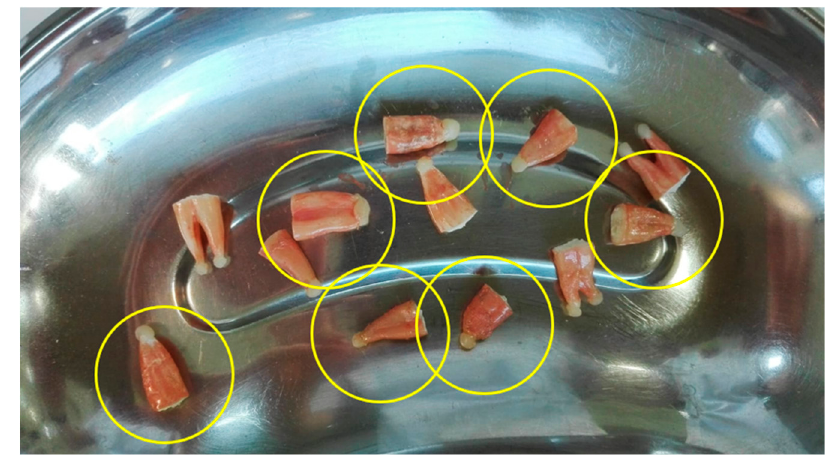
Figure 1. Sealed and sterilized single-canal mandibular